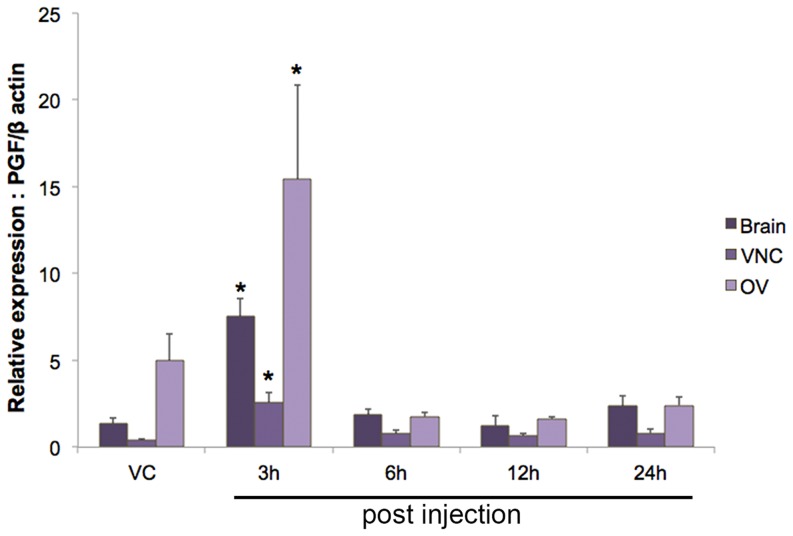
Effect of priming 5-HT on the relative PGFS gene expression levels of S. olivacea using quantitative RT-PCR.
PGFS mRNA expression levels in the brain, VNC and ovary (n = 12) were determined at 3, 6, 12 and 24 h post 5-HT injection. Data were normalized against β-actin. Asterisks indicate significant differences (p<0.05) with respect to the control (vehicle-injected) group. Abbreviations: prostaglandin F synthase (PGFS), ventral nerve cord (VNC), ovary (OV), and vehicle control (VC).